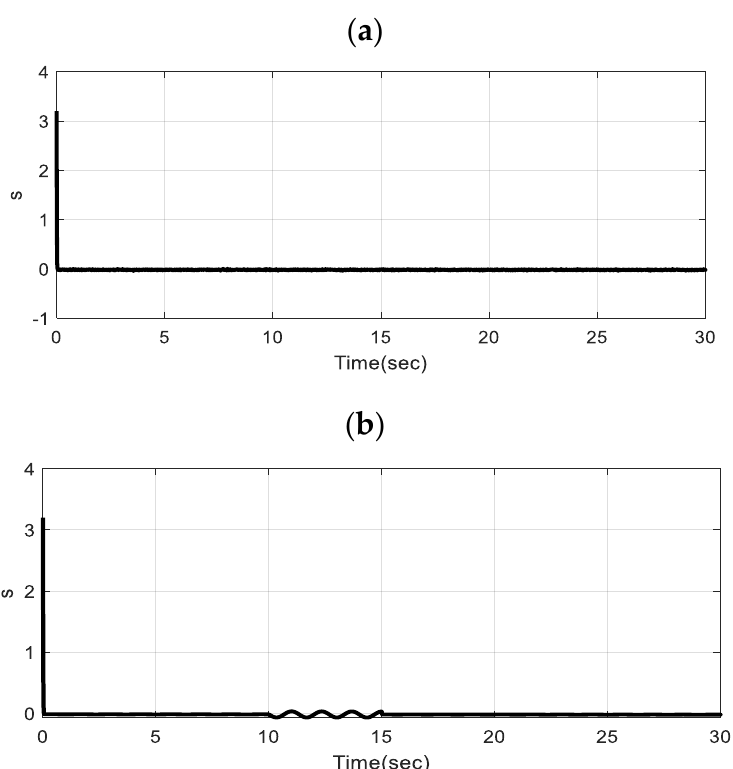
Figure 8. Time histories of a nonlinear sliding surface ( a ) with noise ( b ) in the presence of an abrupt change in disturbance.